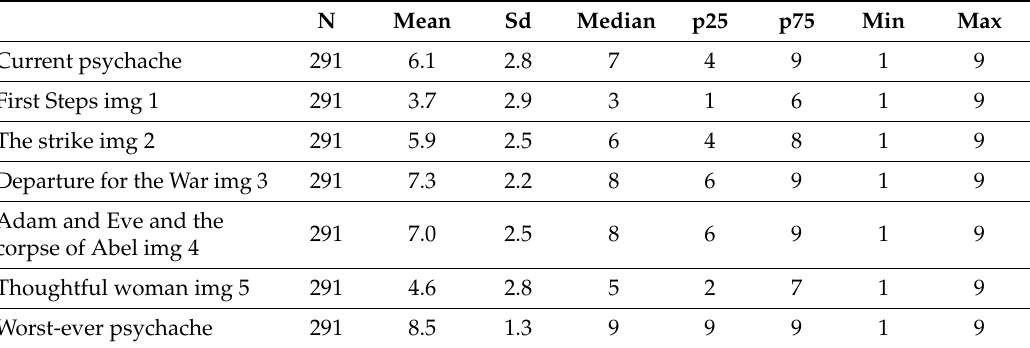
Table 2. Descriptive statistics.